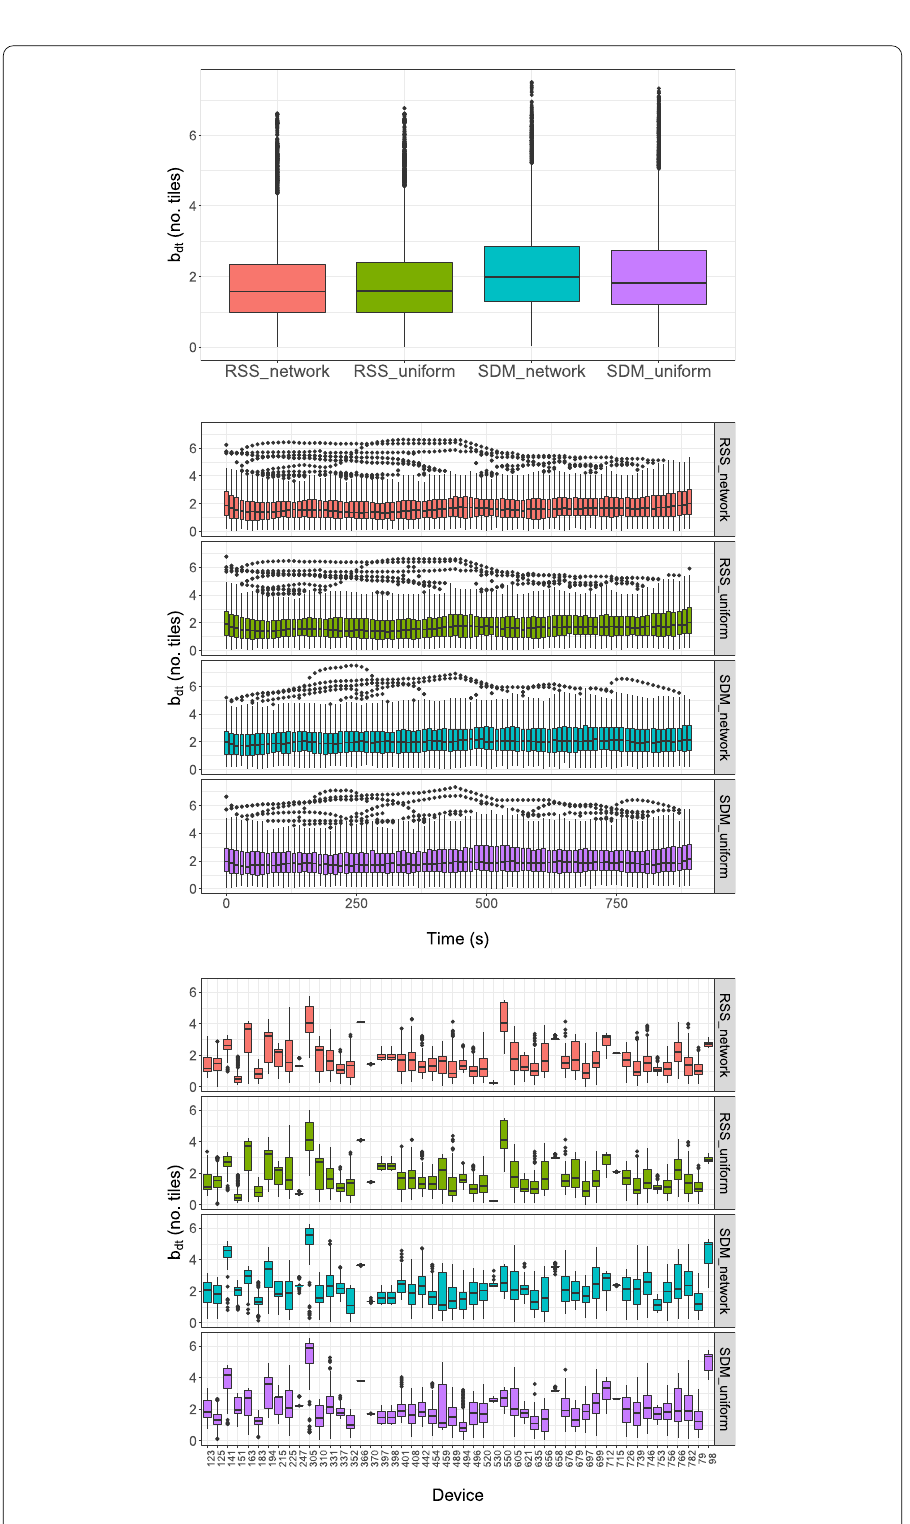
Figure 5 Distance between centers of location probabilities and true positions. (Top) Distribution of distance b dt for all times t and all devices d for models RSS and SDM with uniform and network priors. (Middle) Time evolution of distributions of distance b dt for all devices d for the same models. (Bottom) Distribution per device of distance b dt for all times t for the same models (only 50 randomly selected are